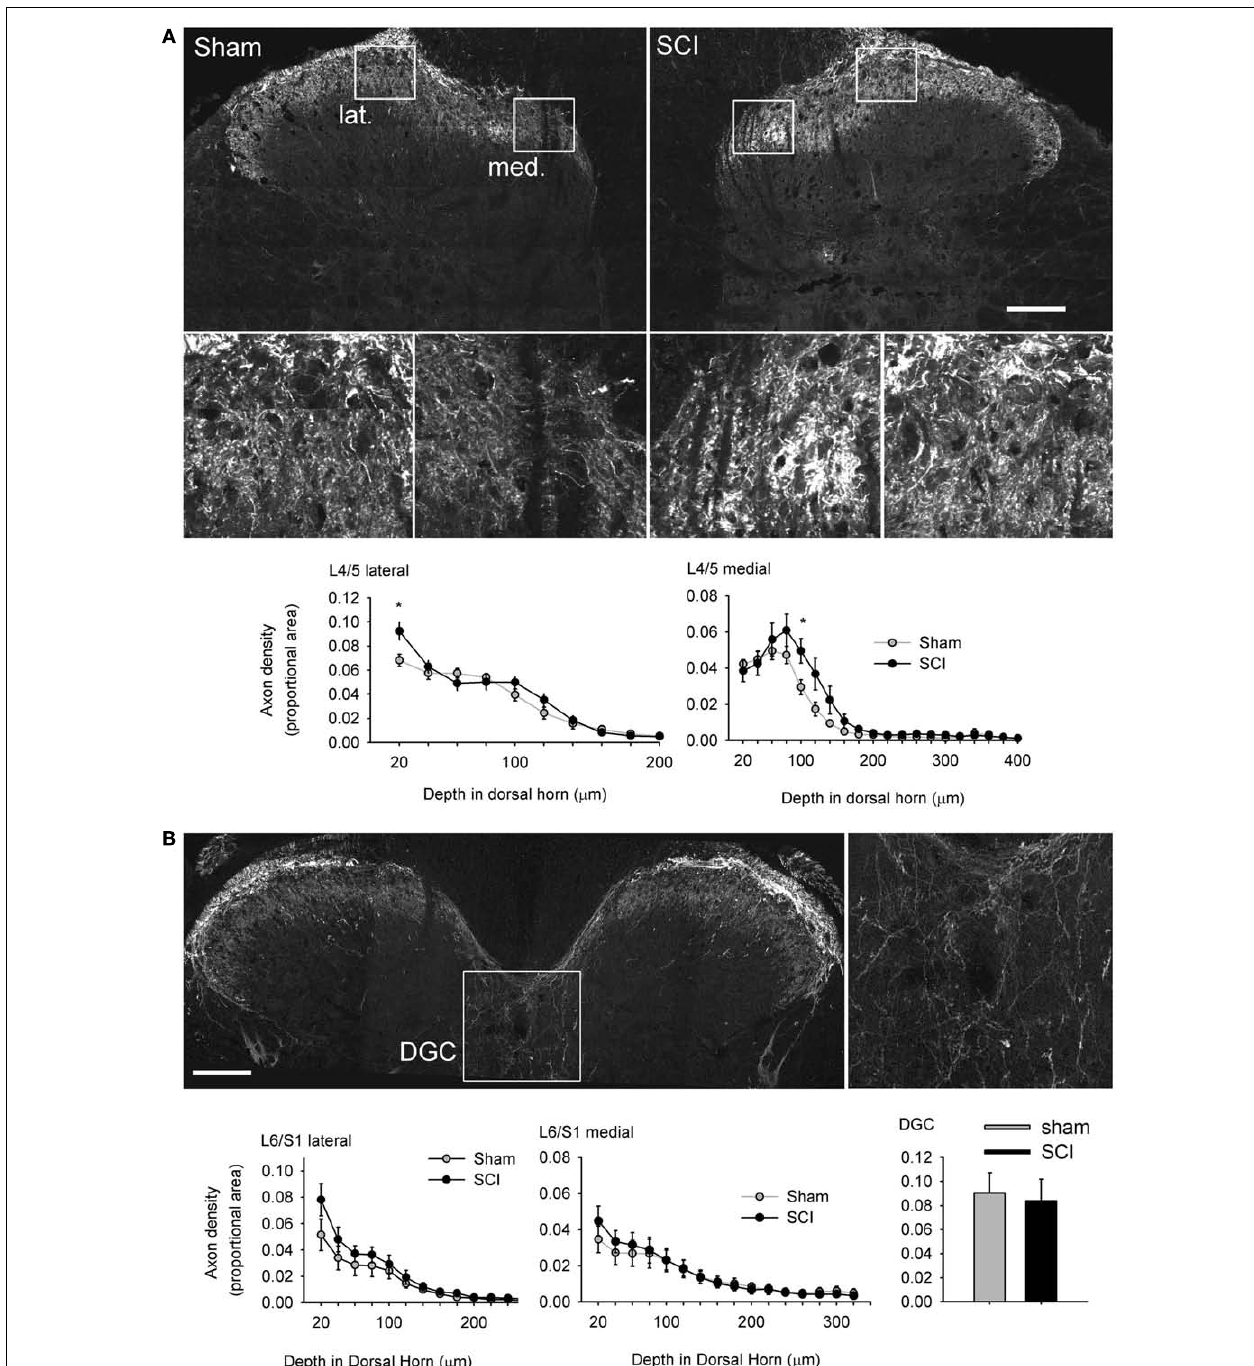
There was no evidence ofTRPV1-positive axon extension into deeper laminae. (B) In the L6/S1 cord, there were no differences between sham-injured orT3 SCI animals in the dorsal horn, or in the dorsal gray commissure (DGC, boxed image enlarged to the right), the terminal field of the visceral medial collateral pathway. Asterisks: P < 0.05, Student’s t -test. Scale bars = 200 µ